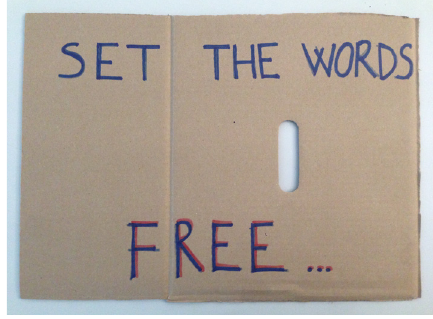
Figure 3. Second stage: writing the